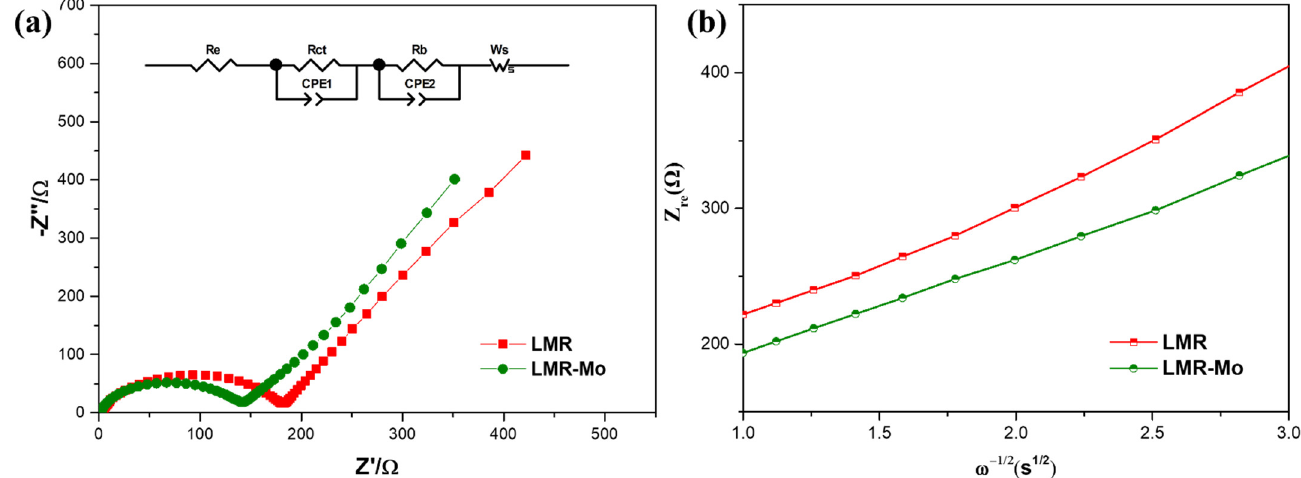
Figure 6. ( a ) Nyquist plots of LMR and LMR-Mo. ( b ) Plots of Z re vs. ω –1/2 .